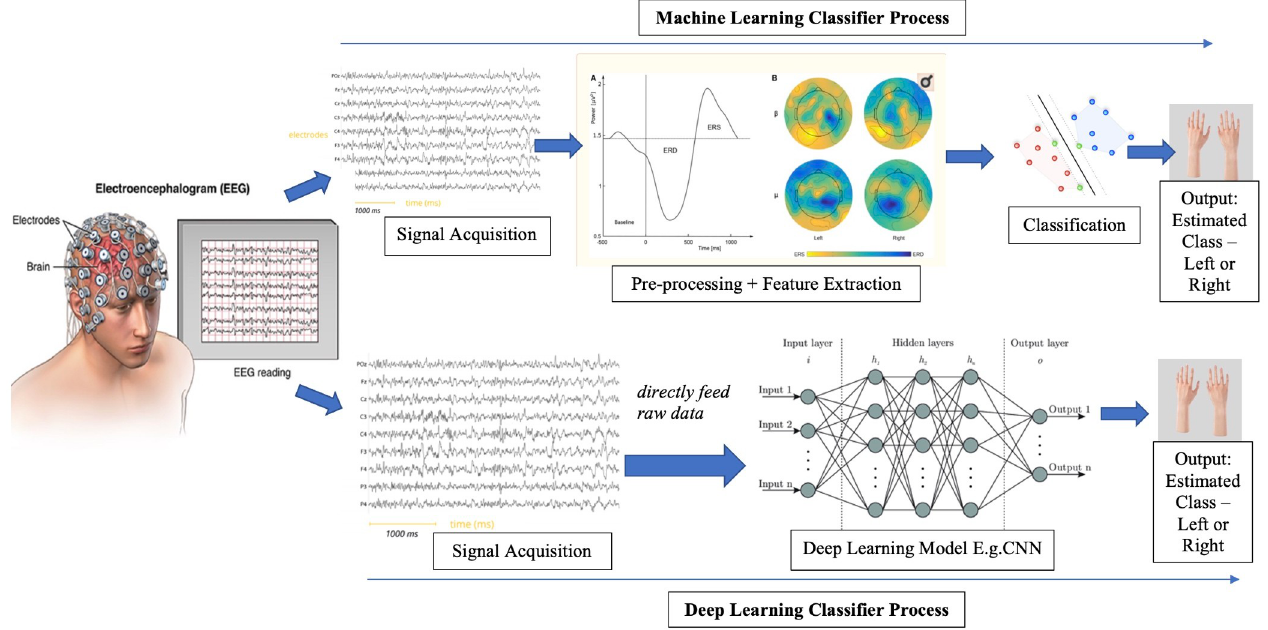
Fig 1. An overview of MI-BCI classification using machine learning vs. deep learning approaches. In ML approach, EEG signals are first pre-processed and relevant features are extracted before applying a classifier. In DL approach, raw signals are directly fed into the model.